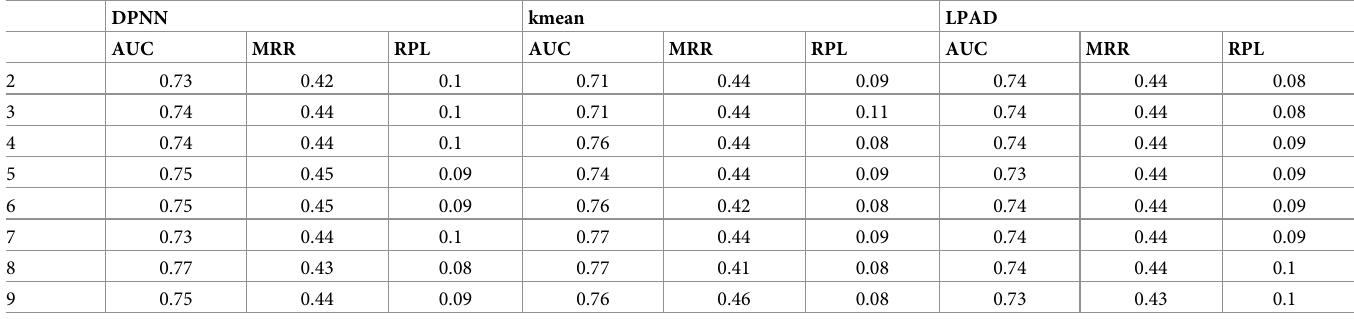
Table 7. Sensitivity analysis- synthetic data. Performance by Number of